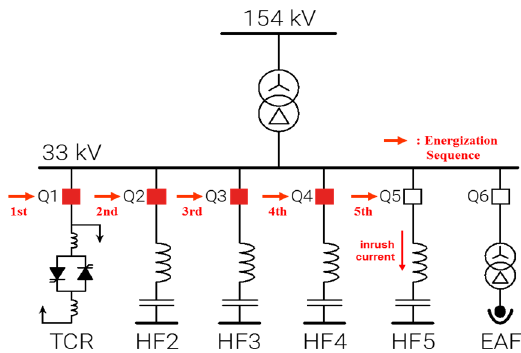
Figure 10. Schematic diagram of four multiple single-tuned filter banks for an electric arc furnace. Table 3. Parameters for thyristor-controlled reactor (TCR) and harmonic filter banks.